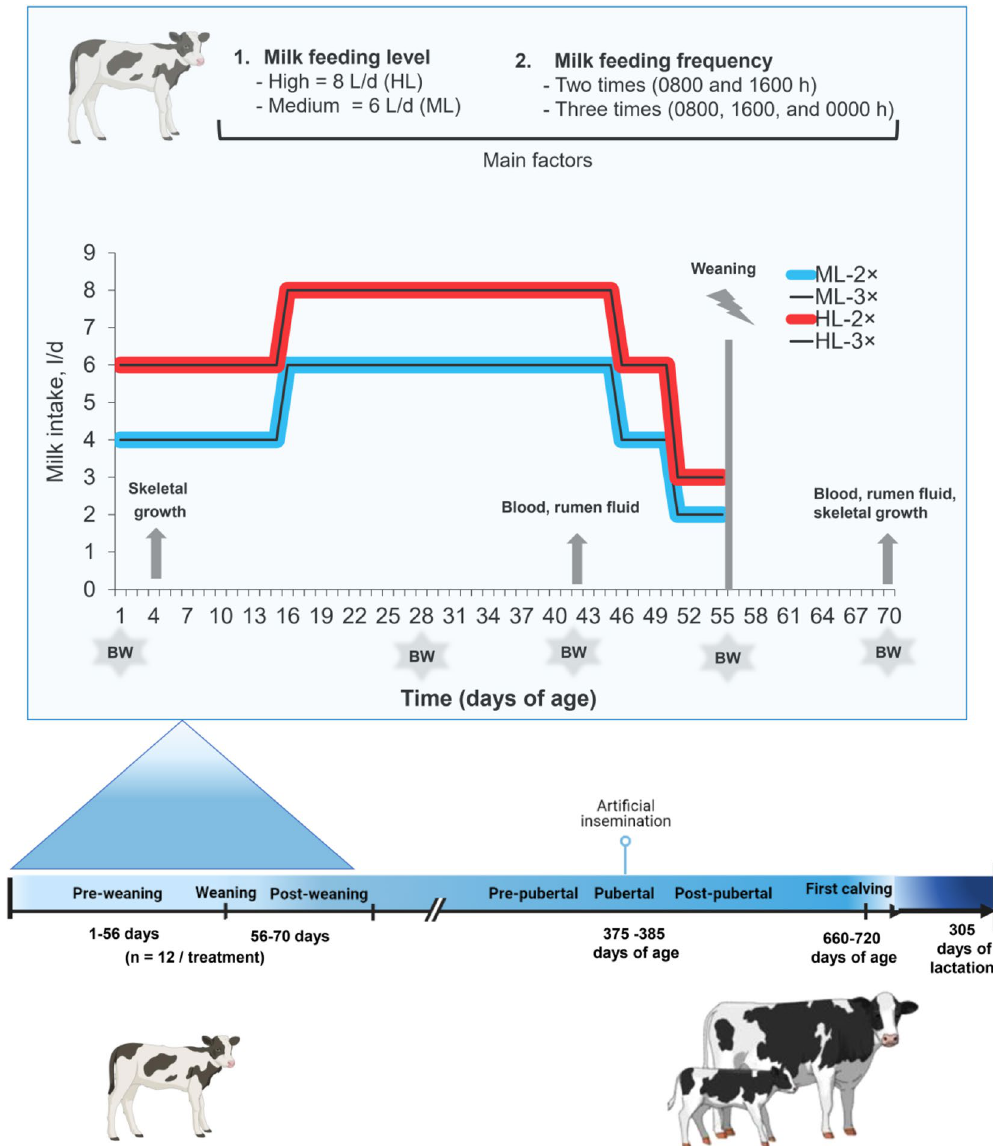
Figure 1. Overview of the animal experiment. The schematic diagram represents the amounts of milk consumed (L/d) by calves fed different amounts of milk and weaned at 56 d of the study. Calves fed medium milk allowance twice or thrice per day (2 × or 3 × ; 4 l/d of milk from d 1–15, 6 l/d of milk from d 16–45, 4 l/d of milk from d 46–50, and 2 l/d of milk from d 51–55 of the study); calves fed high milk allowance twice or thrice per day (2 × or 3 × ; 6 l/d of milk from d 1–15, 8 l/d from d 16–45, 6 l/d from d 46–50, 3 l/d from d 51–55 of the study). Figure created using BioRender (https:// biore nder.